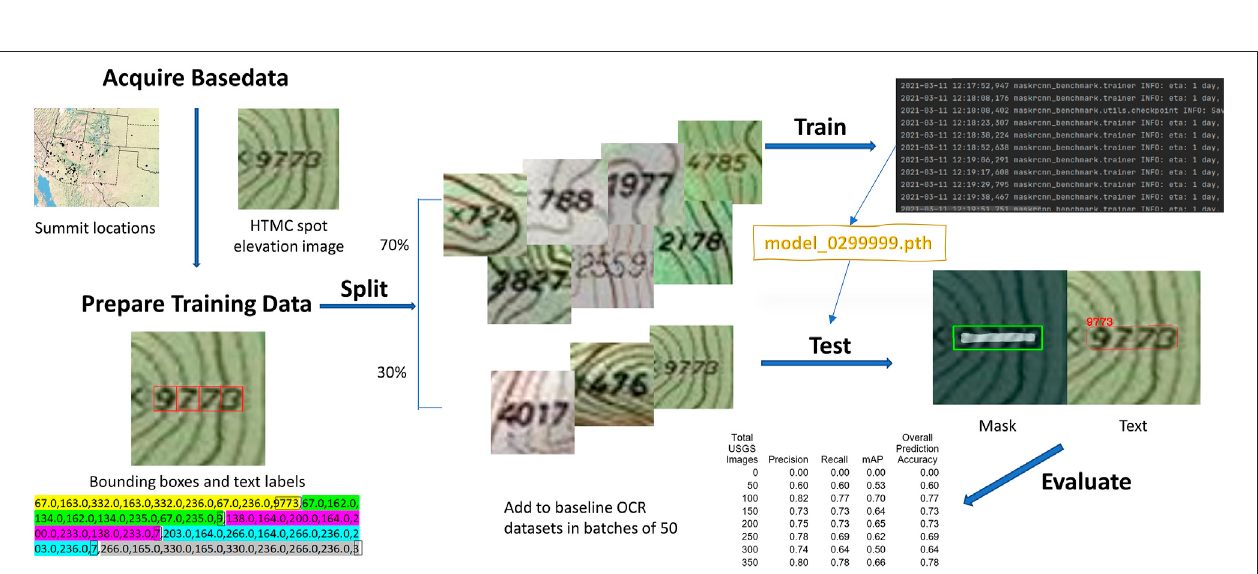
FIGURE 2 | A step-by-step overview of the spot elevation detection and recognition learning work fl ow.